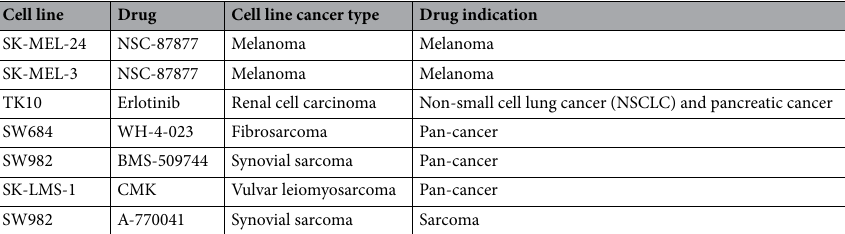
Table 9. ADRML sensitive predictions for novel cell line-drug pairs verified by the latest release of GDSC. These pairs had unknown IC50 in the training dataset and were predicted as a sensitive pair by ADRML. The latest release of GDSC reported these pairs as the sensitive